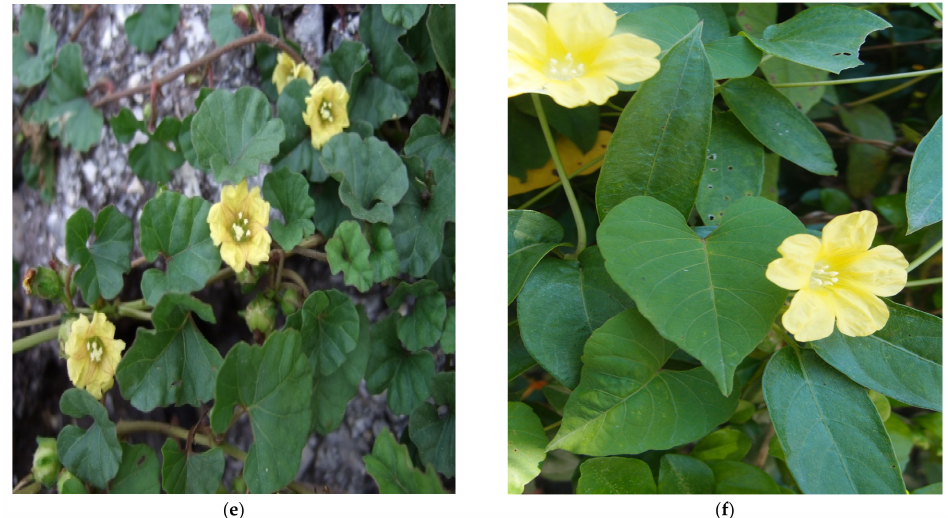
Figure 2. Images of some Merremia species. ( a ) Merremia palmata Image: © Riana Fourie, (CC-BY- NC) [34]. ( b ) Merremia pterygocaulos Image: © Thierrycordenos, (CC-BY-NC) [35]. ( c ) Merremia platylphylla Image: © Alexis L ó pez Hern á ndez [36]. ( d ) Merremia peltata Image: © Matthew Cock [37]. ( e ) Merremia emarginata Image: © Convolvulaceae unlimited [38]. ( f ) Merremia gemella Image: © Wan-hsuan [39].